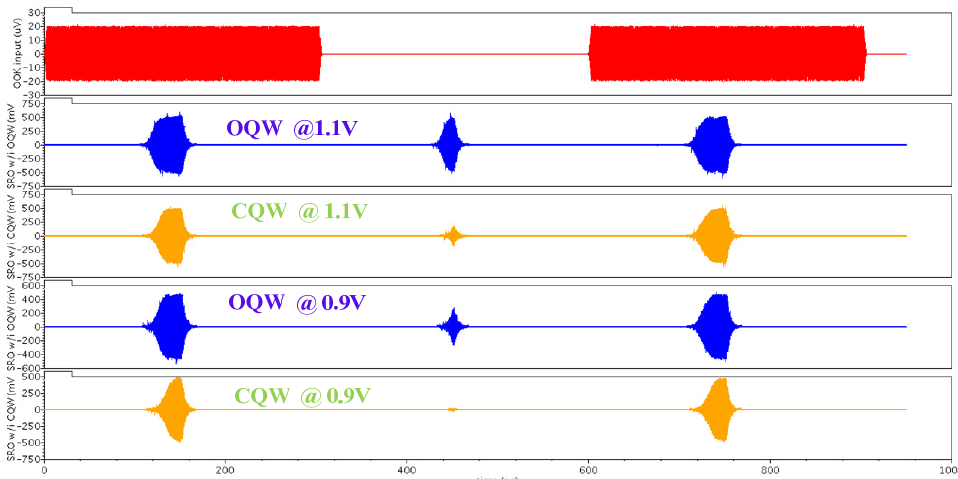
Figure 15. The simulation results illustrating the SRR’s immunity against supply voltage variations. From top to bottom: the input OOK signal, the OQW @ 1.1V, the proposed CQW @ 1.1V, the OQW @ 0.9V, and the proposed CQW @ 0.9V.